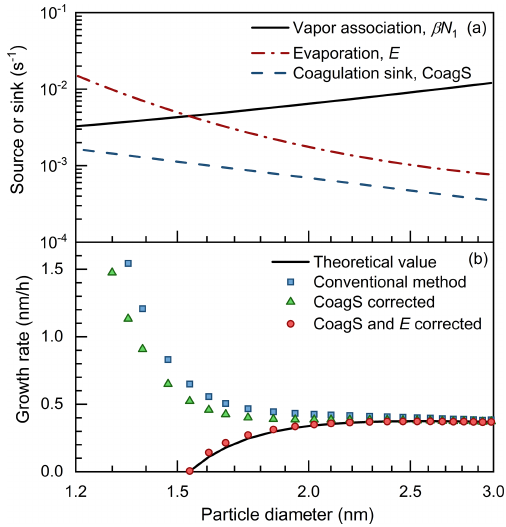
Figure 6. The impact of vapor evaporation on the appearance time method. (a) The size-dependent vapor association rate ( βN 1 ) , evap- oration rate ( E) , and coagulation sink (CoagS). (b) The theoretical net condensation grow rate and the growth rate retrieved using con- ventional and corrected appearance time methods. The theoretical growth rate is defined in the Lagrangian specification; i.e., it is cal- culated using βN 1 − E